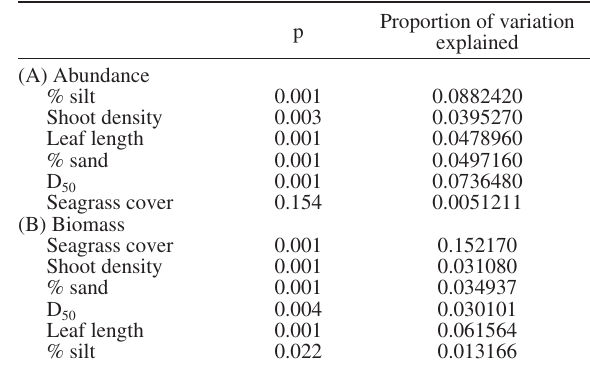
Table 3. – Results of the multiple regressions tests (sequential tests) testing for significant relationships between predictor variables and